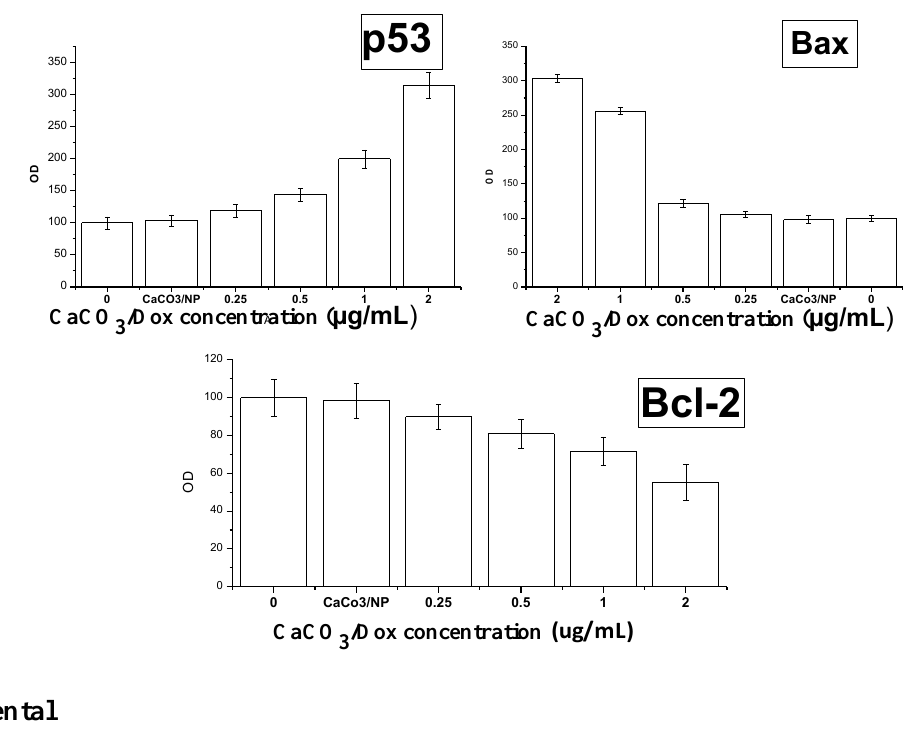
Figure 12. Up-regulation of p53 and Bax and down-regulation of Bcl-2 through the effect of CaCO /Dox nanocrystals on MG 63 3